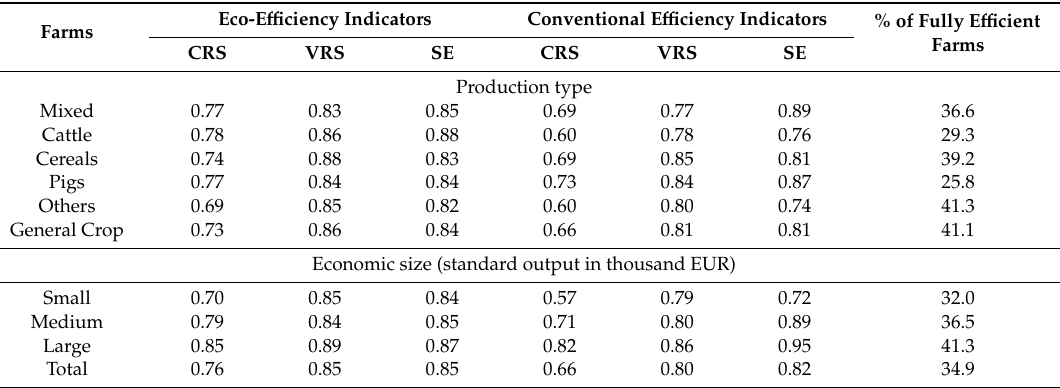
Table 4. Average eco-e ffi ciency indicators calculated with the data envelopment analysis (DEA) method, depending on production type and economic size classes, and the share of fully e ffi cient farms in the sample of Polish commercial